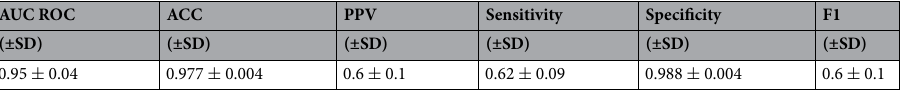
Table 1. Binary classification metrics for the final fivefold cross-validated algorithm for the H-2K b typing. The reported mean statistics estimators correspond to AUC ROC, accuracy (ACC), precision or positive predictive value (PPV), and sensitivity and specificity with their harmonic average (F1). The prevalence of positive samples was around 1:40.